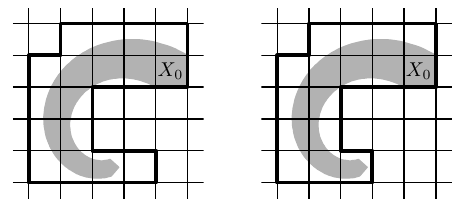
Figure 5: Reachable set of a dynamical system (shaded area), and reachable sets of automata (cells within bold